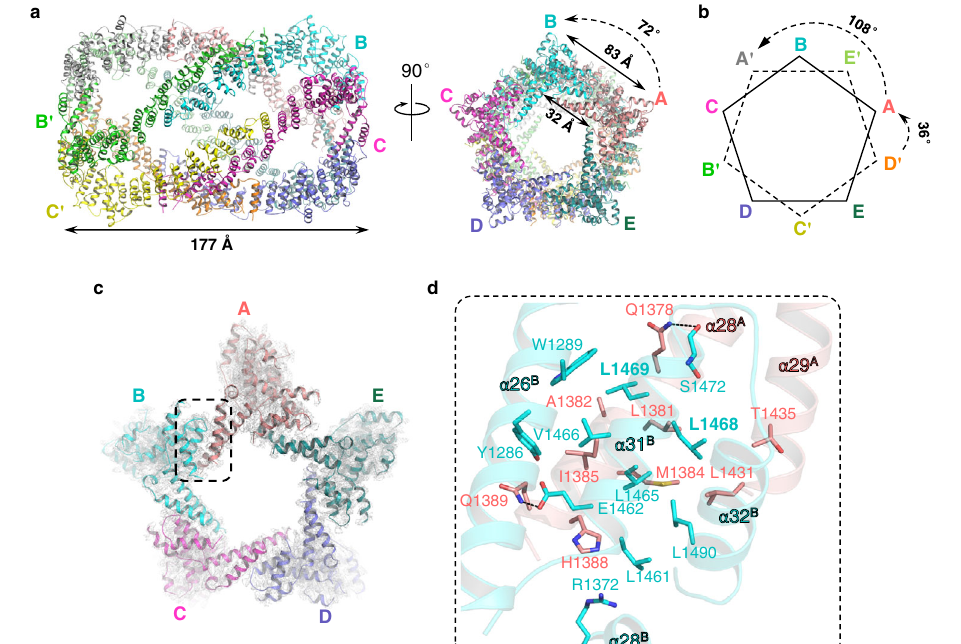
The interface between molecules A and B is indicated by a dashed rectangle. d Close-up interaction of the protomer – protomer interface. Residues involved in intermolecularinteractionsareshowninsticks.Hydrogenbondsareshowninblack